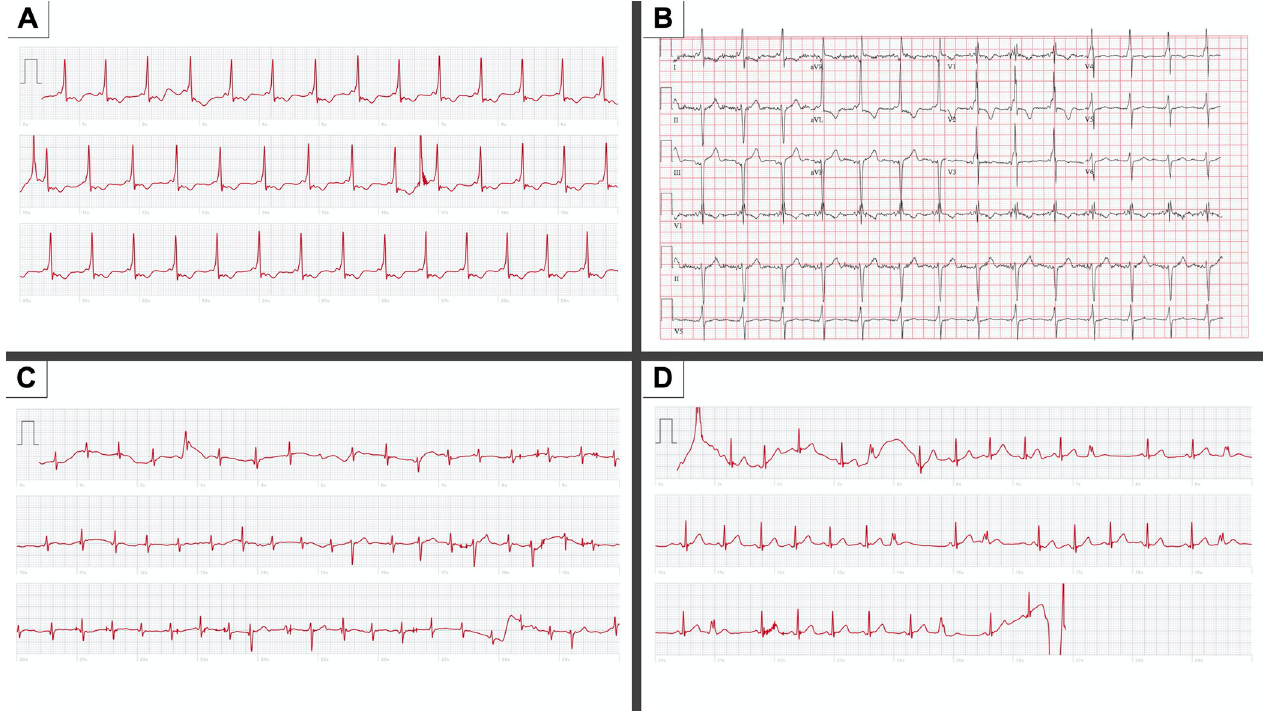
Fig 6. Apple Watch 6 ECG examples. Simultaneously obtained AW6 and 12-lead ECGs of a patient with WPW. Pre-excitation is evident on both the (A) AW6 tracing and (B) 12-lead ECG. (C) AW6 tracing of a 6-year-old female. The AW6 automated interpretation incorrectly labeled this tracing as atrial fibrillation. Physician over-read was sinus rhythm with PACs. (D) AW6 tracing of a 2-year-old female capturing frequent PVCs. The AW6 automated reading was “inconclusive due to poor recording). This tracing also demonstrates how movement artifact appears on AW6 tracings. Additionally, this was the only time a tracing less than 30 seconds saved during the study. Typically, if contact was broken before 30 seconds, the tracing would not save and the 30 second process needed to be started over.